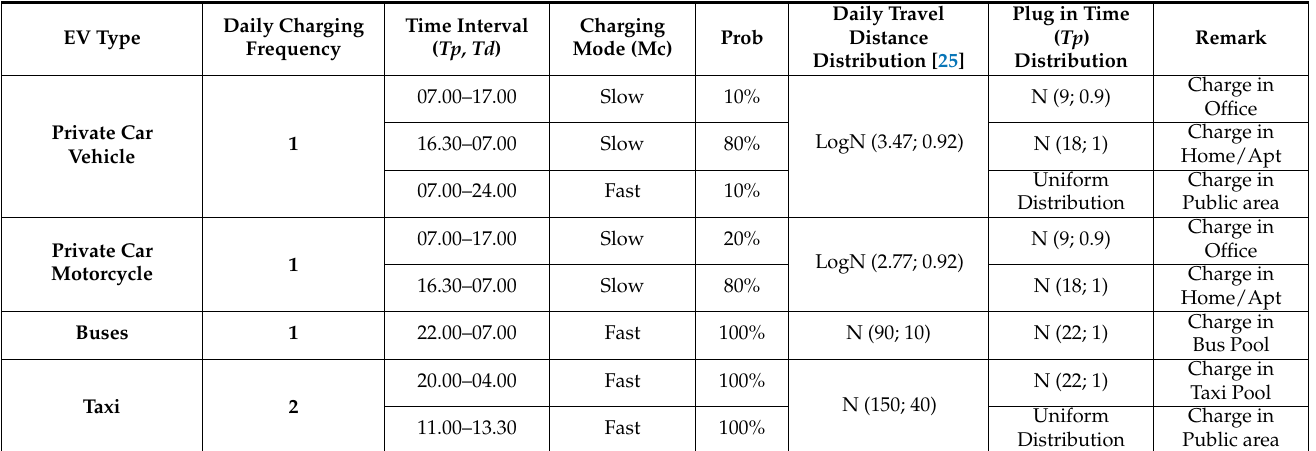
Table 3. Monte Carlo parameters for electric vehicle charging